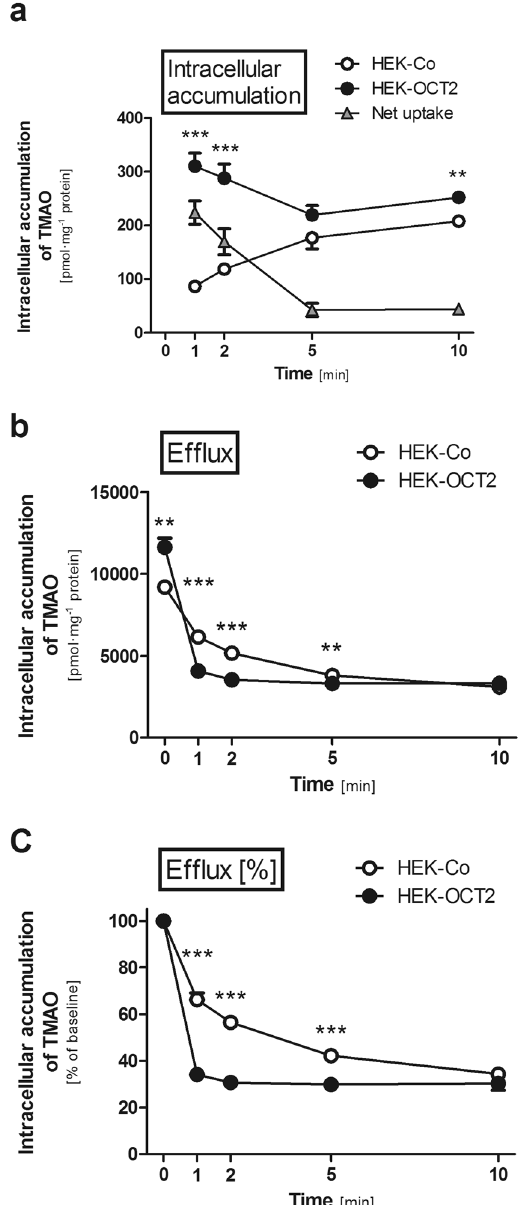
Figure 5. Time-dependent intracellular accumulation and efflux of TMAO (10 µ M) in HEK cells expressing OCT2 (HEK-OCT2) and control cells (HEK-Co). ( a ) TMAO intracellular accumulation measured at 1, 2, 5, and 10 min. ( b ) Efflux experiments: cells were preincubated for 60 min with TMAO (300 µ M) and subsequently the extracellular medium was replaced with buffer without TMAO. Intracellular accumulation of TMAO was measured after 0 (baseline), 1, 2, 5, and 10 min. ( c ) The same data as in (b) with intracellular accumulation at baseline set to 100%. Data points are 2 × n = 2 at 1, 5, and 10 min and 4 × n = 2 at 0 and 2 min, mean ± SEM, ** p < 0.01 vs. HEK-Co, *** p < 0.001 vs.